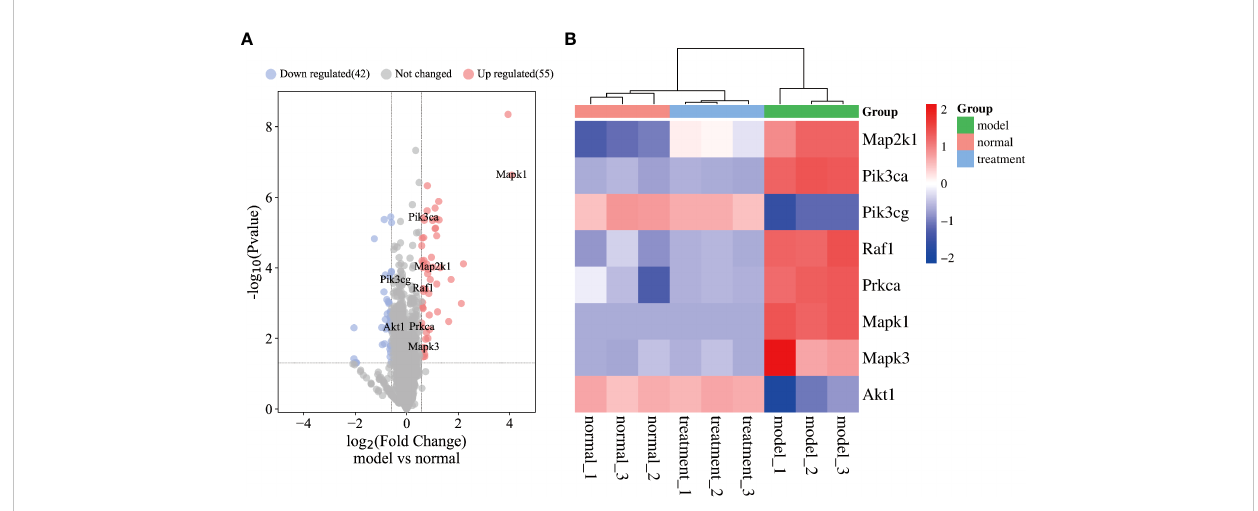
FIGURE 6 Results of proteomics. (A) The volcano plot of model group vs control group. (B) The heatmap of key